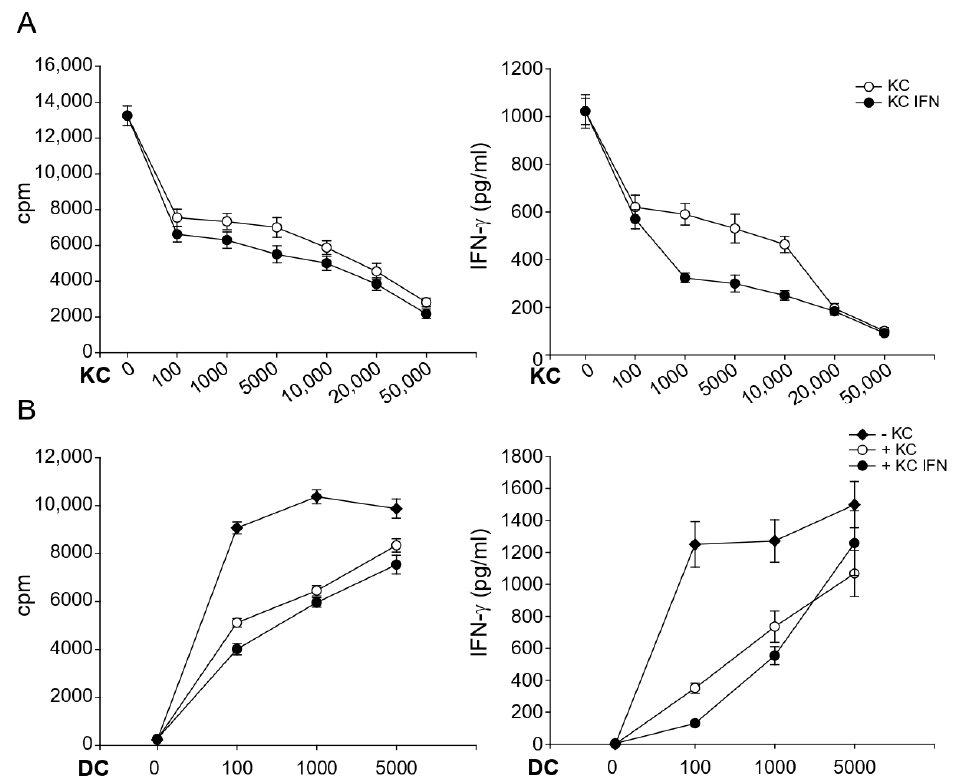
Figure 3. The modulatory capacity of keratinocytes is dose-dependent and dependent on the strength of antigen presentation. Nickel-specific T cell clones (1 × 10 5 ) were incubated together with nickel sulfate, autologous DCs (1 × 10 3 ) and different numbers of unstimulated keratinocytes ( A ) or with 1 × 10 4 keratinocytes and different numbers of DCs ( B ). Proliferation and cytokine production was measured after 48 h by 3 H-thymidine and ELISA, respectively. Shown are the representative results of one nickel-specific Th1 clone (n =